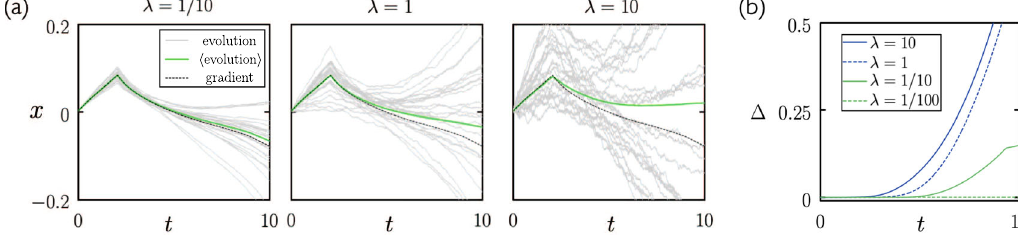
Fig. 2 The smaller the neuroevolution mutation scale, the closer the neuroevolution-gradient descent correspondence. a Time evolution of a single neural-network weight, for three different neuroevolution mutation scales [see (14)]. b The quantity Δ ( t ), Eq. (15), is a measure of the difference between networks evolved under gradient descent and neuroevolution.